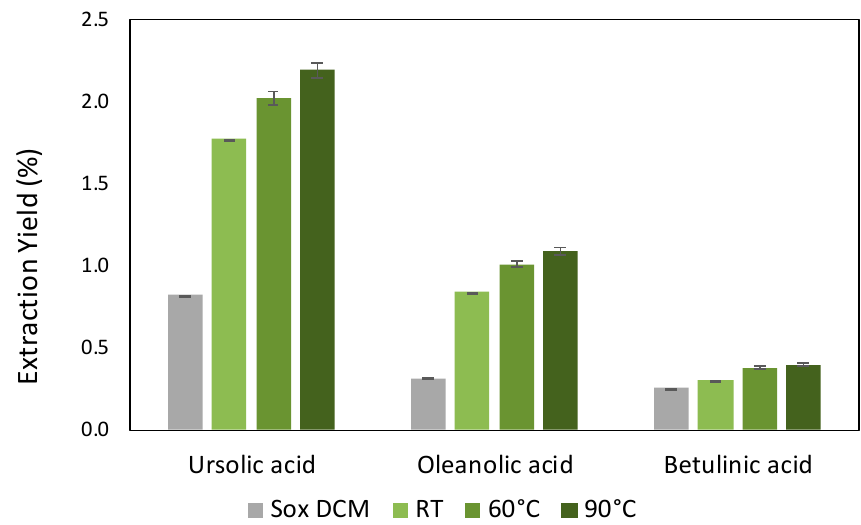
Figure 6. Extraction yields of ursolic, oleanolic and betulinic acids, using Soxhlet extraction with dichloromethane, and simple solid–liquid extraction with the NADES menthol:thymol 1:2 (0.15 g biomass/g DES), at room temperature (RT), 60 and 90 °C.